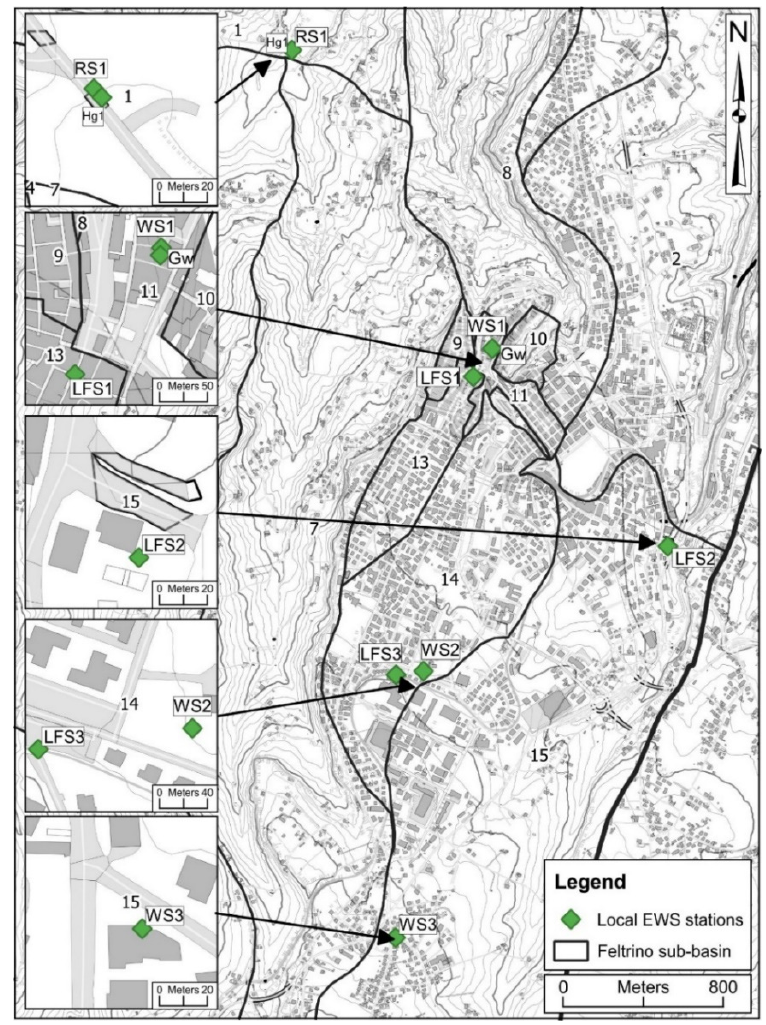
Figure 17. Location of the urban network gauges for the urban Early Warning System (EWS) of Lanciano. Labels refer to Table 7.